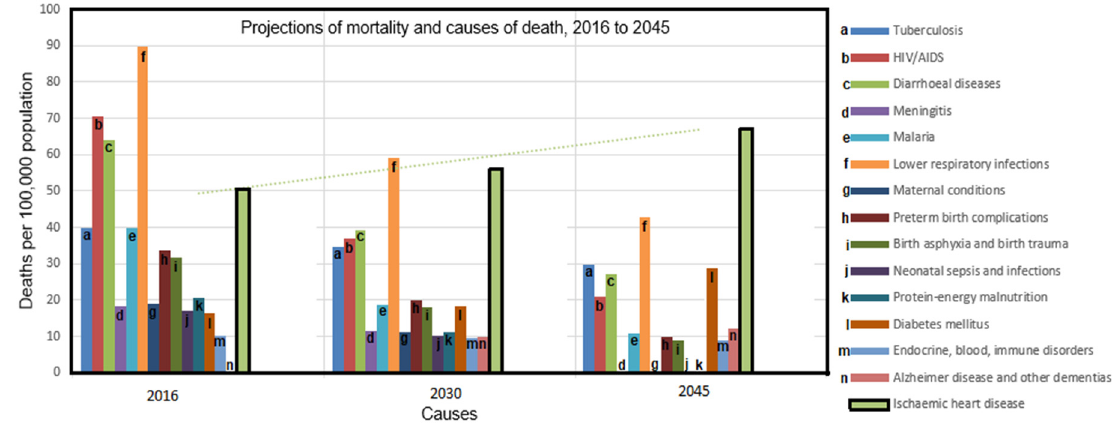
Figure 2. The projection of mortality and cause of death between 2016 to 2045 shows an exacerbation of IHD in Africa [13].